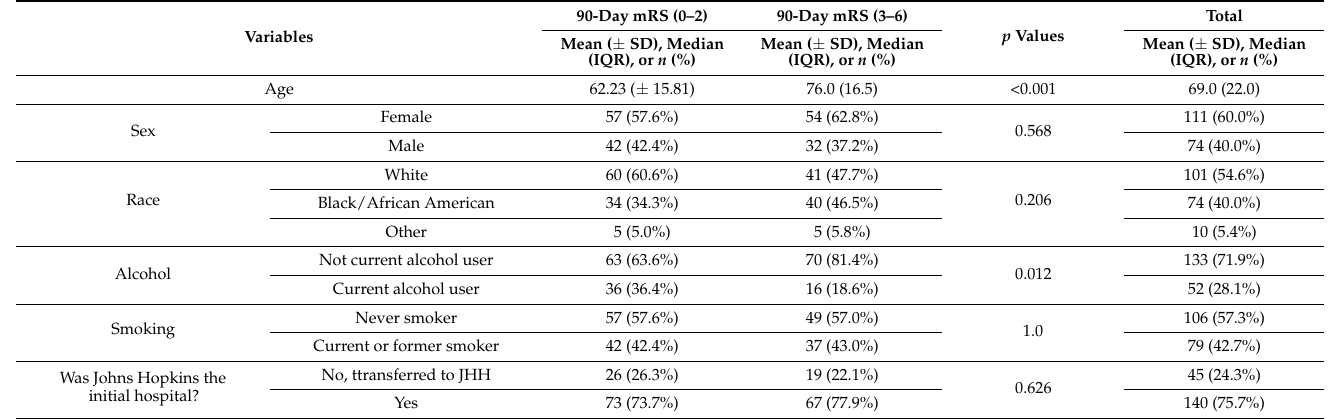
Table 1. The characteristics of the patient population utilized in mRS